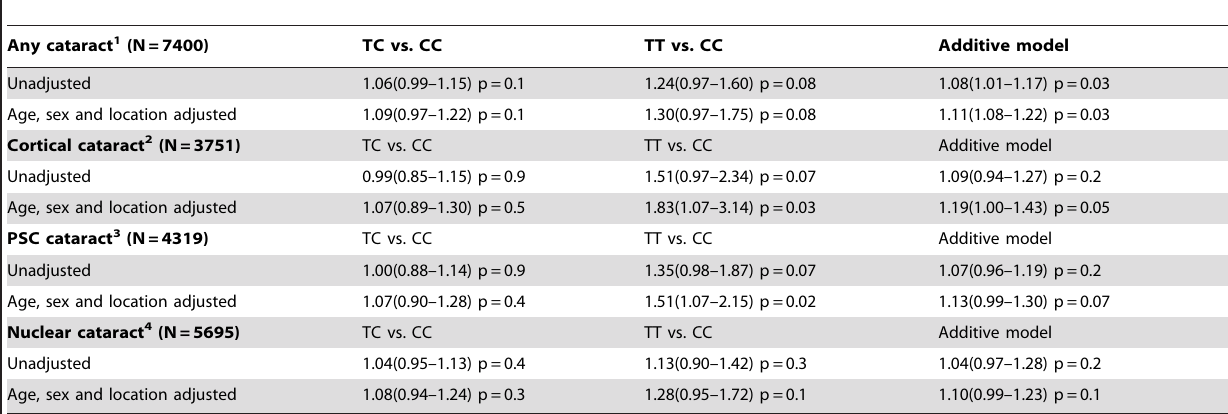
Table 4. Associations between cataract and